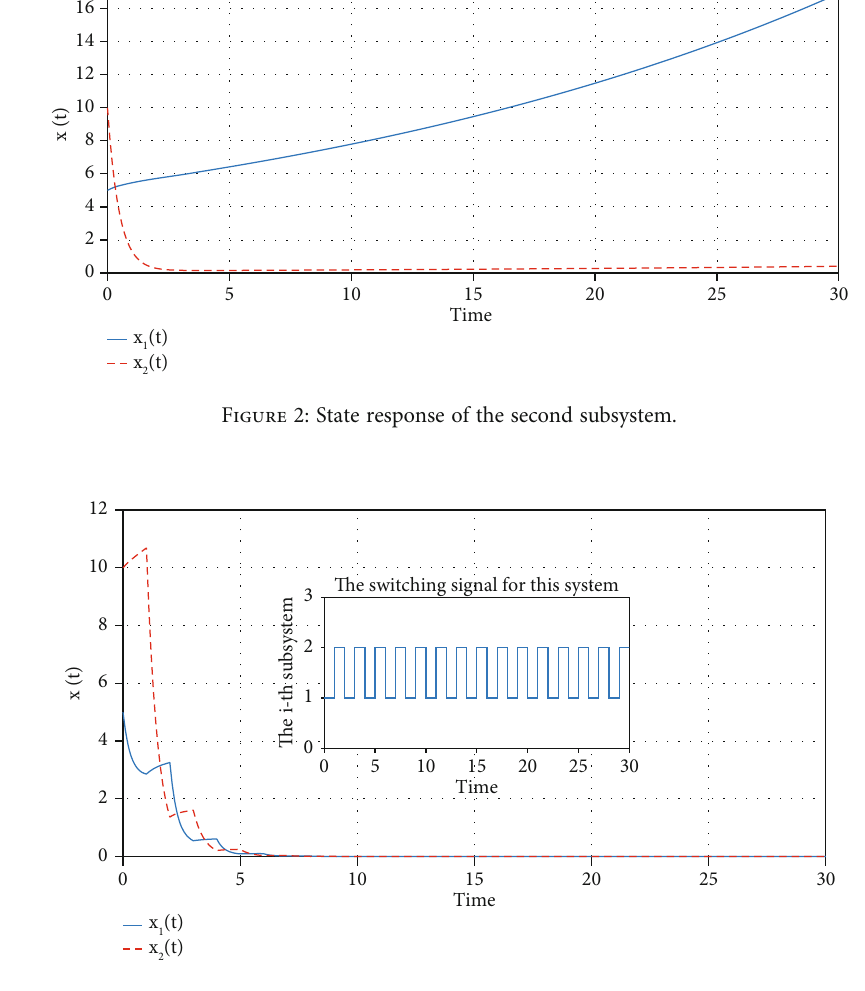
Figure 3: State response of the continuous-time system.